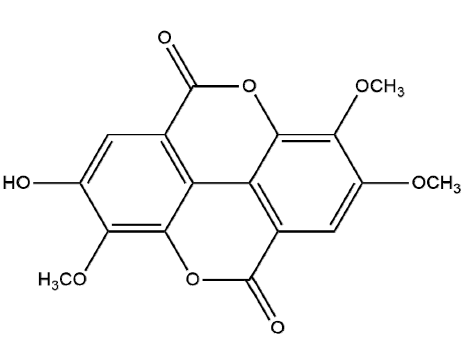
Figure 2. Structure of compound 2 .